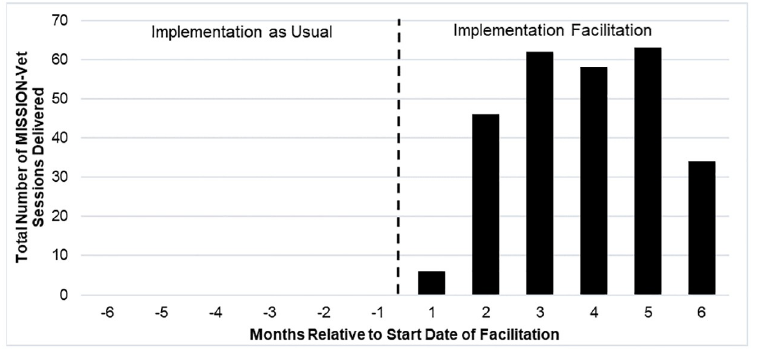
Fig 2. Total number of MISSION-Vet sessions delivered across 2 VAMCs by month relative to the start of facilitation.